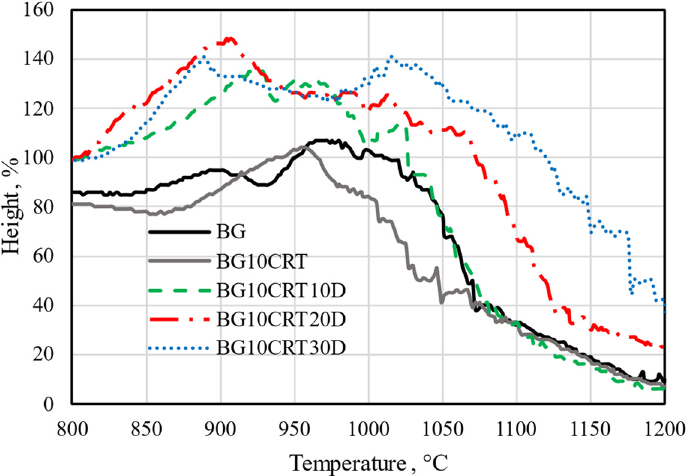
Figure 4. Sintering curves of glass foams with SLS glass (BG), 10 wt% CRT and 10, 20, and 30 wt% dross (BG10CRT10D, BG10CRT20D, BG10CRT30D).